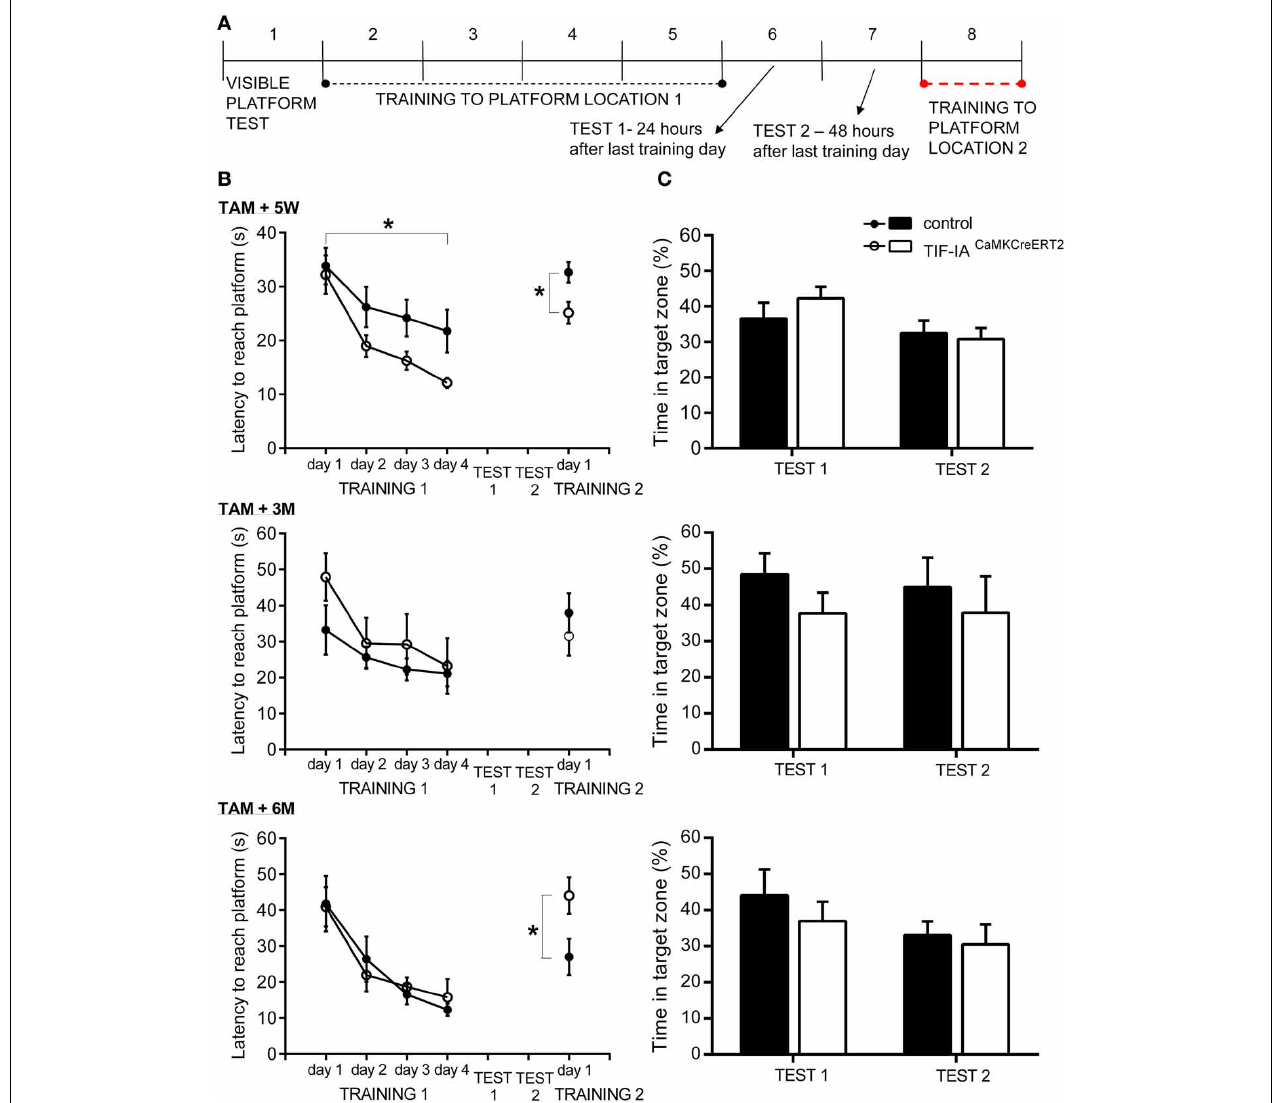
FIGURE 7 | TIF-IA CaMKCreERT2 mutant mice show enhanced learning. (A) Morris water maze procedure. Trials order in subsequent days. (B) Spatial learning in Morris water maze 5 weeks, 3 and 6 months after tamoxifen. Time to find a hidden platform in 4-day learning and 1-day re-learning is shown. Enhanced learning abilities in mutant compared to control mice ( p < 0 . 05) were observed 5 weeks after induction of mutation. Deterioration in 1-day re-learning task was found in mutants 6 months after tamoxifen. No